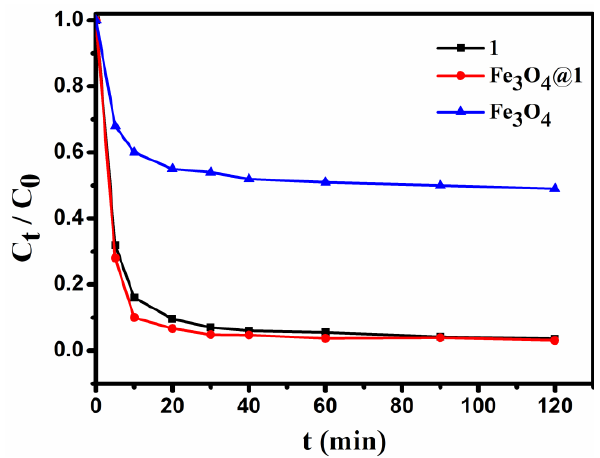
Figure 10. The changes in concentration of the MB dye solution.